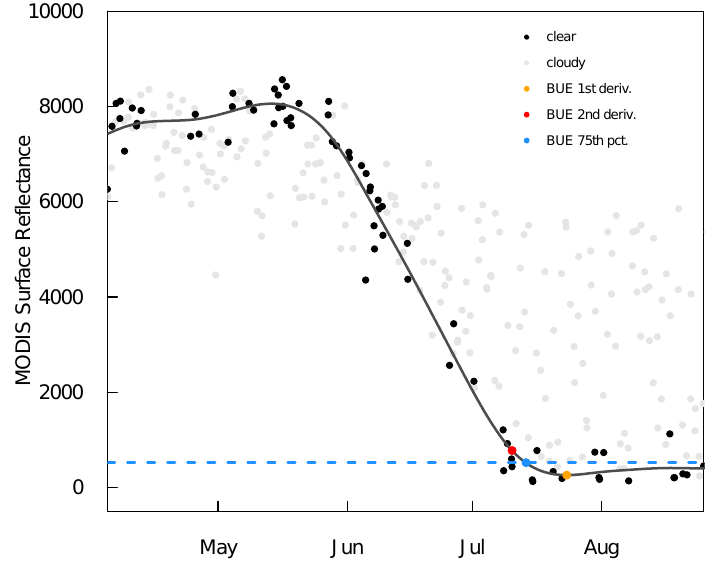
Figure 4. Example time series of lake-wide mean MODIS surface reflectance from year 2012. Clear observations are shown in black points, while cloudy observations are shown in gray points. A smoothing spline fit to the clear observations is shown in the solid line. BUE estimates from the first and second derivatives of the smoothing spline are shown in orange and red points, respectively. The blue dashed line shows the 75th percentile of summer (July 20 – August 31) surface reflectance for clear observations, and the blue point shows estimated BUE based on when the spline curve first intersects this threshold.